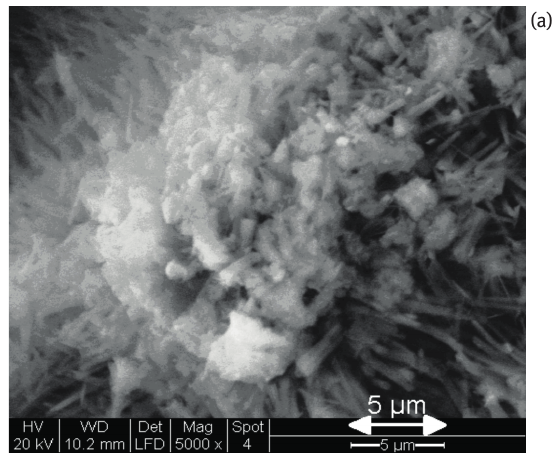
= 2.1 μm by DLS). m